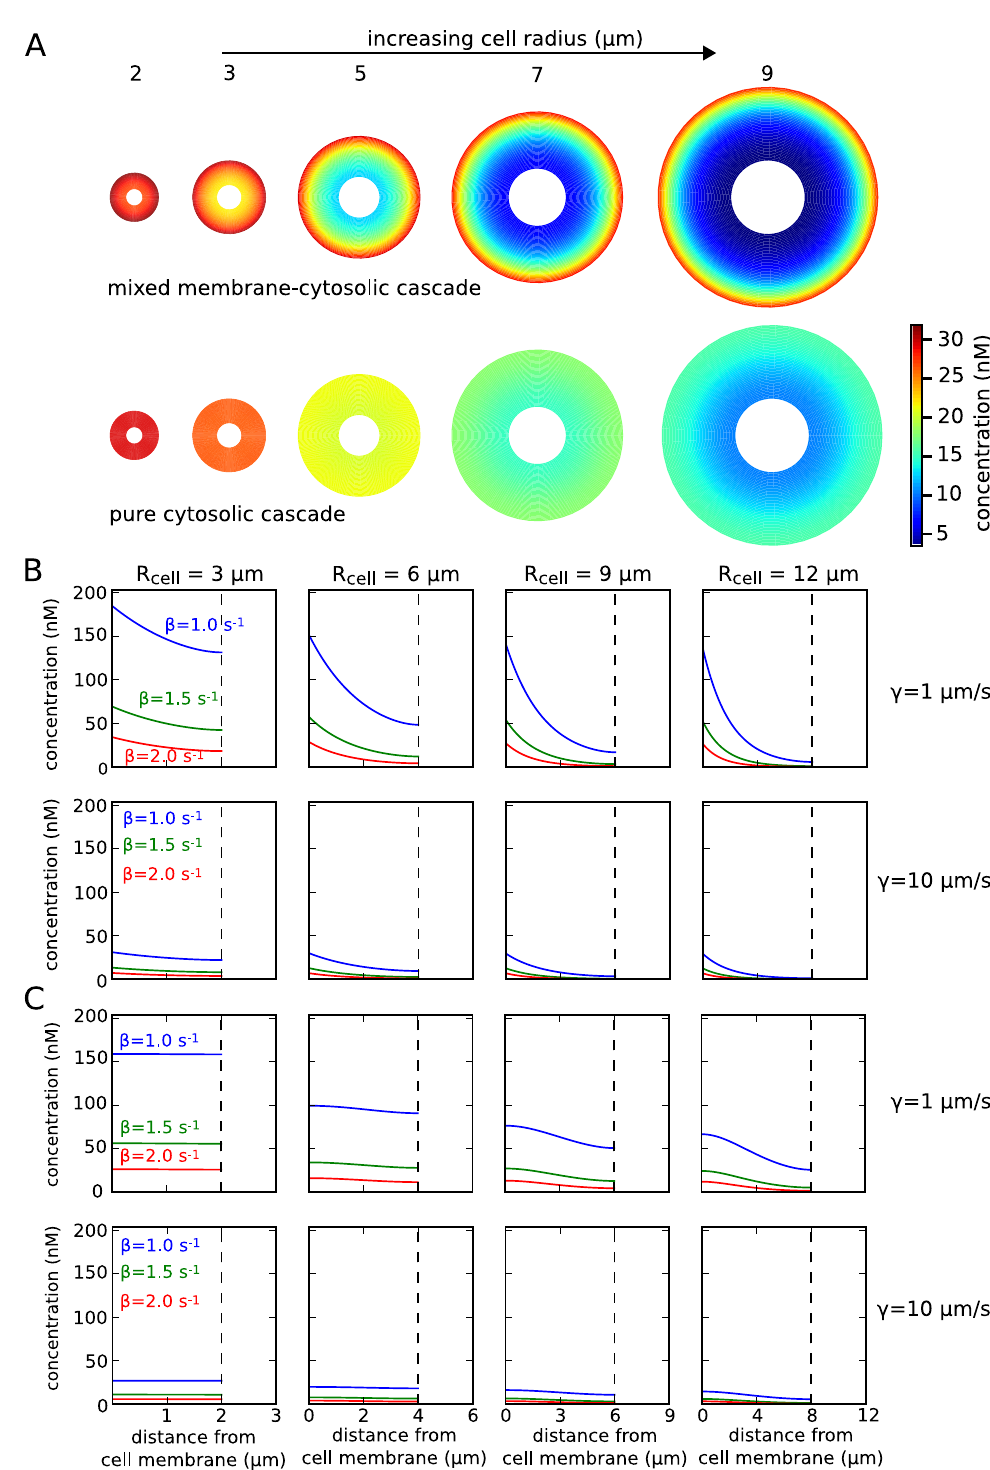
Fig 2. Intracellular concentration profiles for two different signal transduction motifs. ( A ) Concentration of the third cascade element P 3 was plotted along a slice through three-dimensional cells of varying size. Numbers above the cells indicate their radius. Intracellular gradients are steeper for the MMC cascade [upper row] than for the PC cascade [lower row]. The parameters used were α 1 = α 2 = α 3 = 1.5 s −1 , β 1 = β 2 = β 3 = 1.0 s −1 , D mem = 0.03 μm 2 s −1 , D cyt = 3.0 μm 2 s −1 , γ = 10.0 μm s − 1 , P 0 (cid:17) 100 n M μm . ( B ) Size dependence of the MMC cascade with two membrane-bound and one cytosolic species. ( C ) Size dependence of the PC cascade. The nuclear membrane is indicated by a dashed